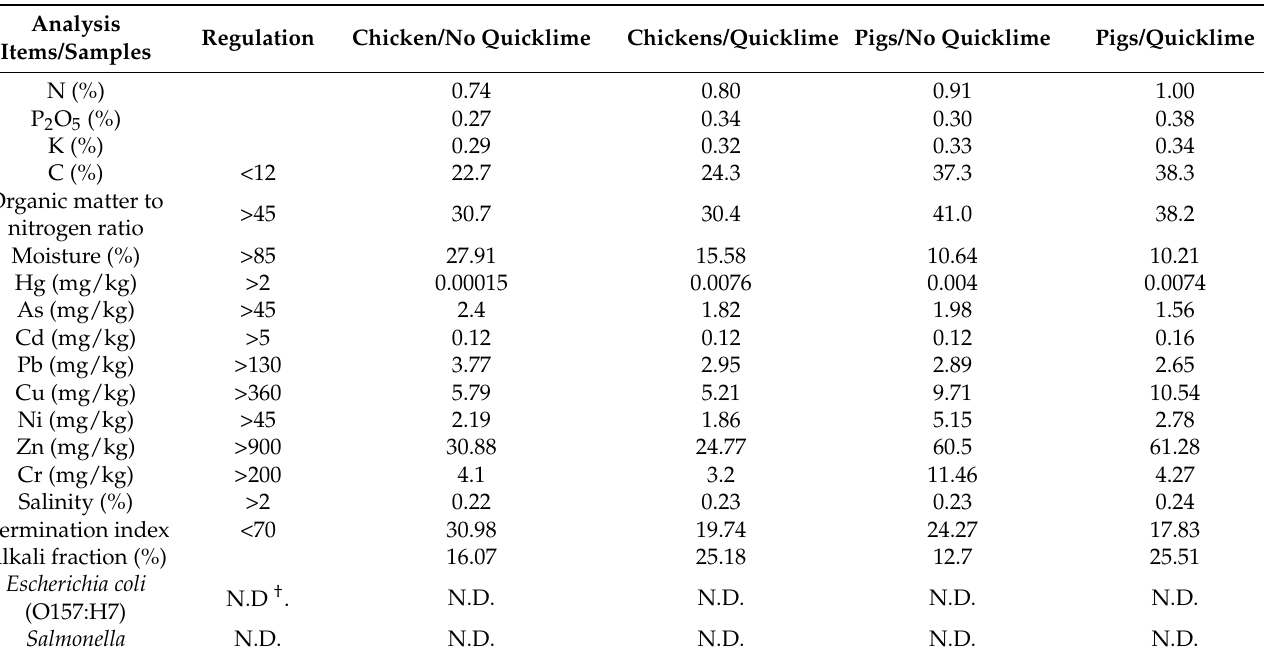
Table 1. Chemical properties of thermos-chemically treated carcass of chicken and pigs with Korean standard regulation for compost use.